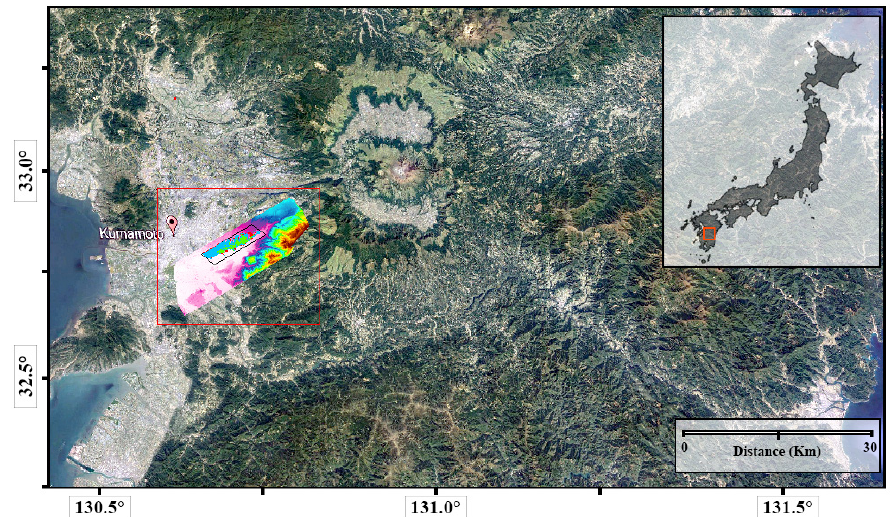
Figure 1. The location of pre- and post-event light detection and ranging (LIDAR) data and the study area [19]. Table 1. Registration date and other details of synthetic aperture radar (SAR) and LIDAR data.